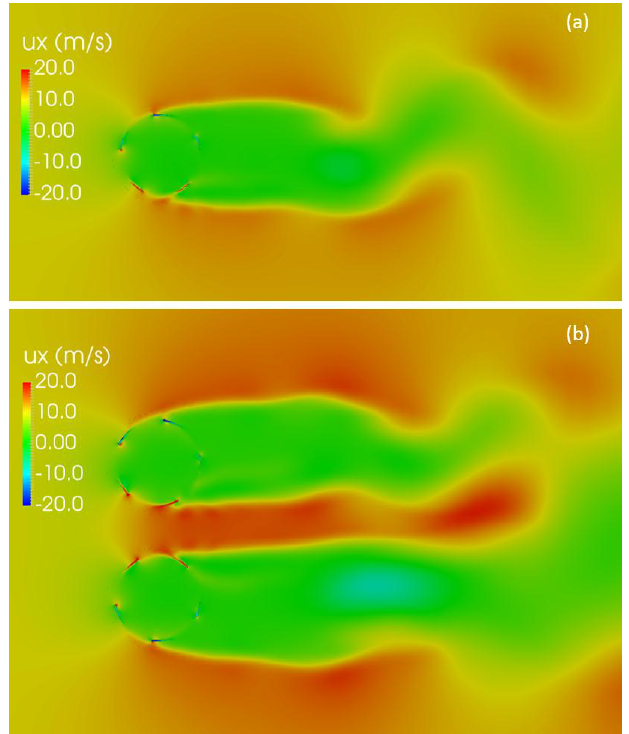
Figure 10. Snapshots of the velocity fields generated by ( a ) an isolated rotor, and ( b ) a pair of rotors. Both are steady-state rotations with ambient velocity u = 10 m/s. The same velocity contour scale was used.